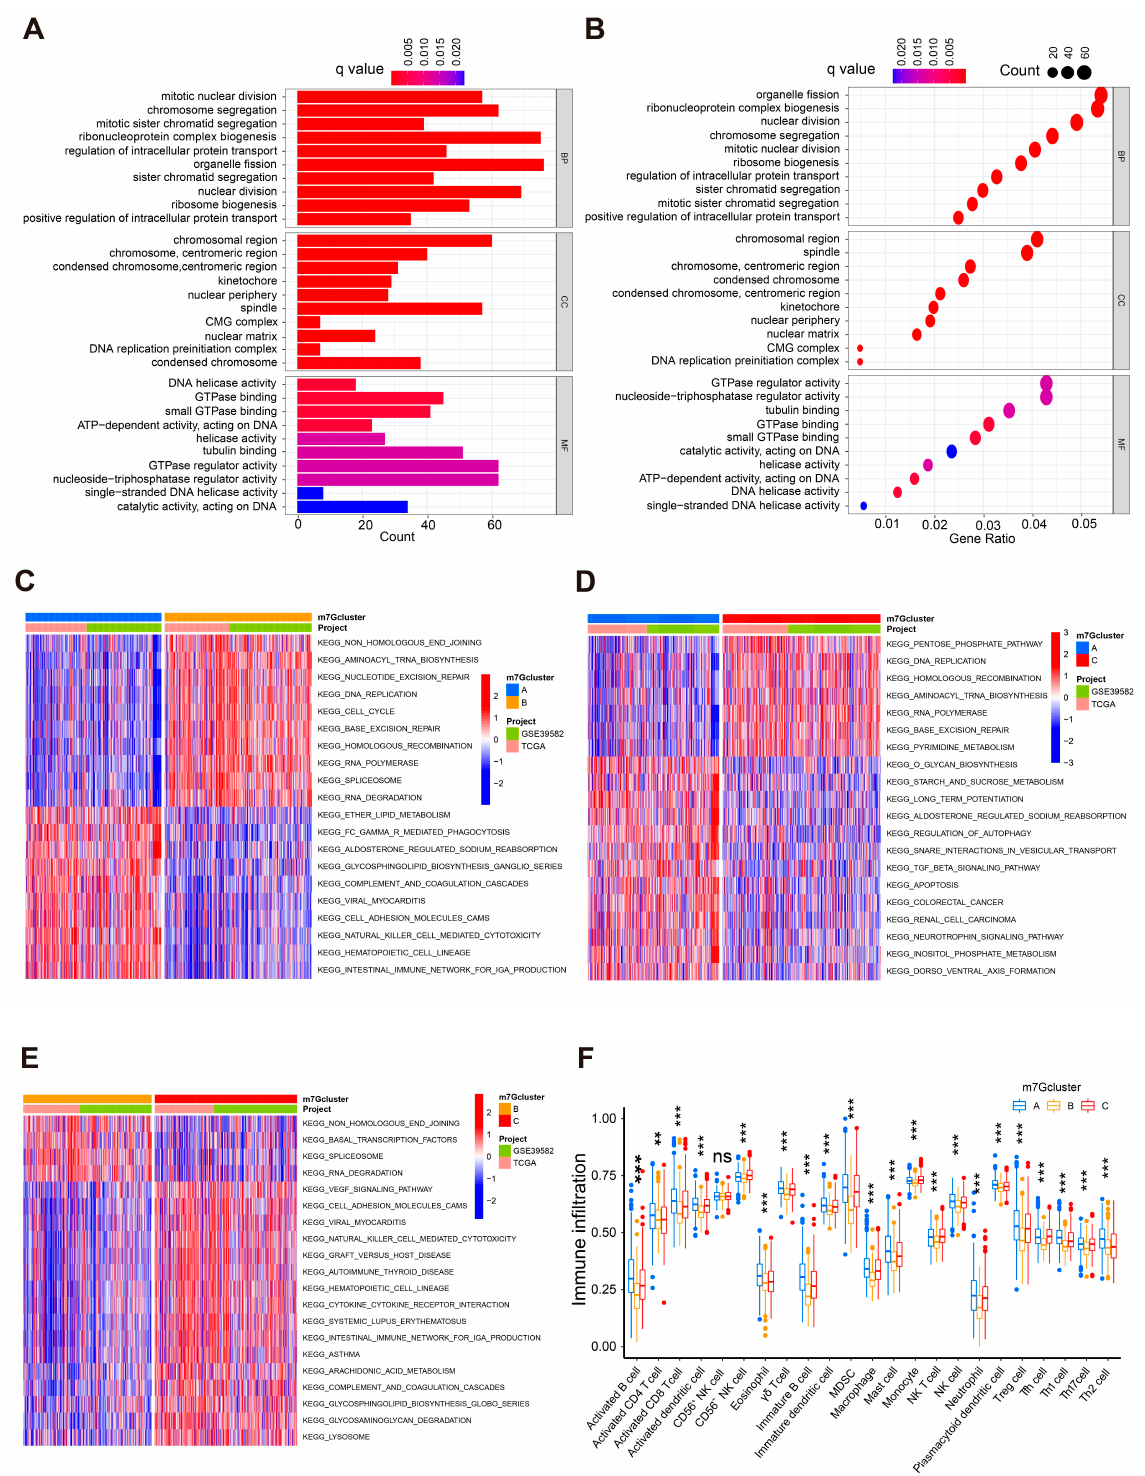
Figure 3. Biological characteristics and immunocyte infiltration information of three m7G Clusters. ( A , B ) GO analysis for the differentially expressed genes from different m7G clusters. ( C – E ) Heatmaps of the remarkably different pathways among different m7G groups by GSVA analysis. ( F ) The boxplot for immune infiltration among CC patients from different m7G groups. * p < 0.05, ** p < 0.01, *** p < 0.001.